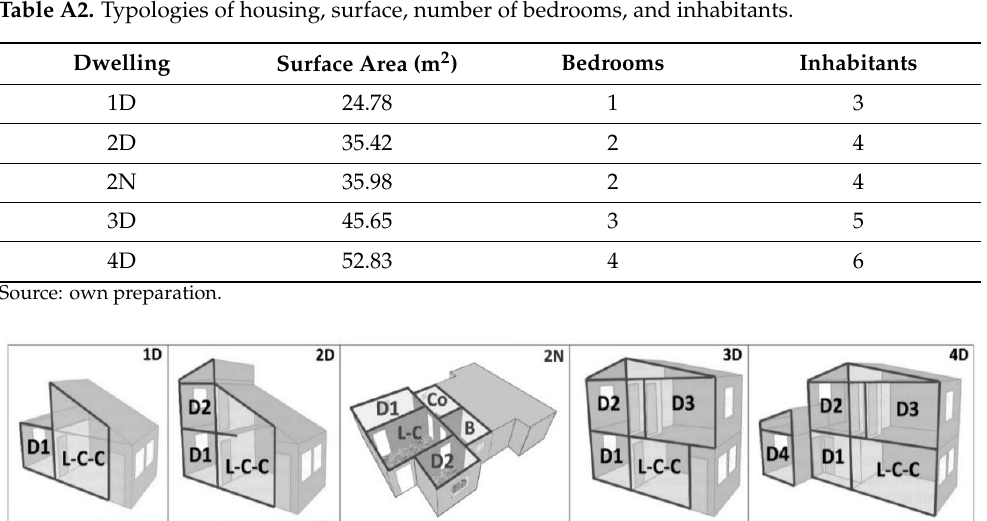
Figure A4. Classification of interior areas in housing models (authors’ own preparation).